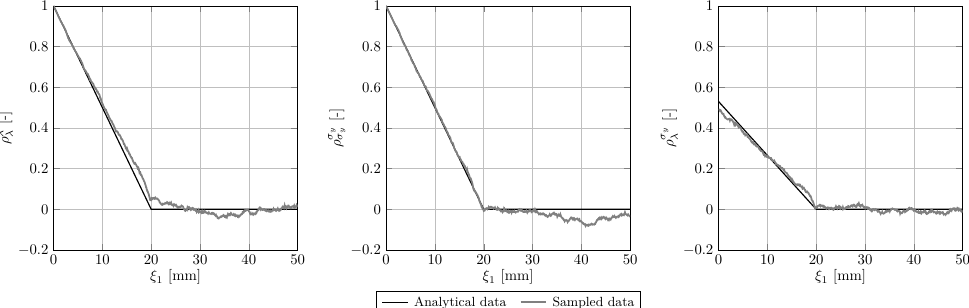
Figure 4. Correlation analysis of the generated cross-correlated random fields.